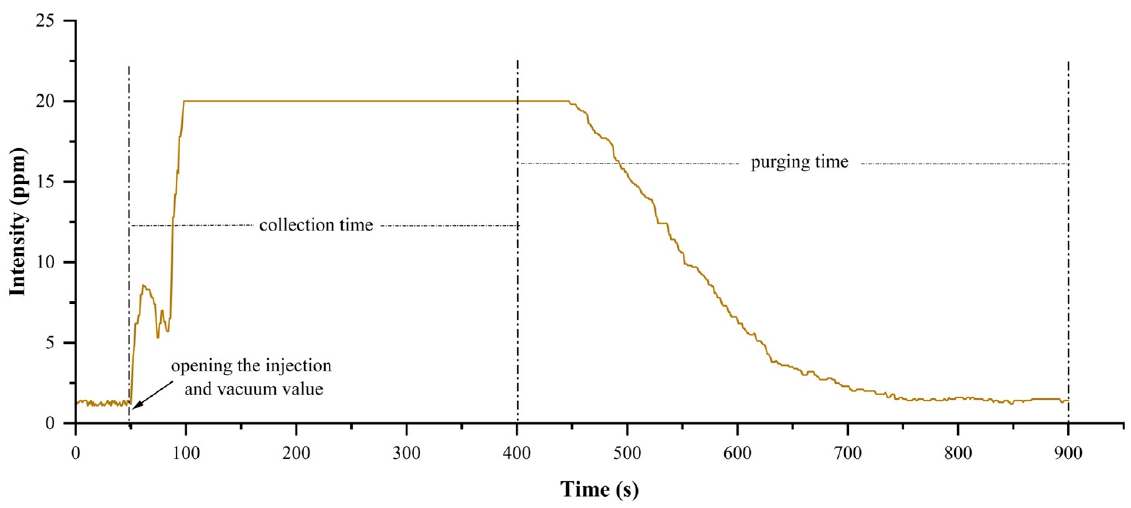
Figure 2. The response curve of the No. 1 sensor C 2 H 4 -20 during the entire sample-collection period. When opening the injection and vacuum valve at 50 s, the collection time lasts 350 s, and the purging of the electronic nose lasts 500 s. Table 1. Types of gas-sensitive sensors in the portable electronic nose sensor array, and their sensi- tive gas and detection accuracies.